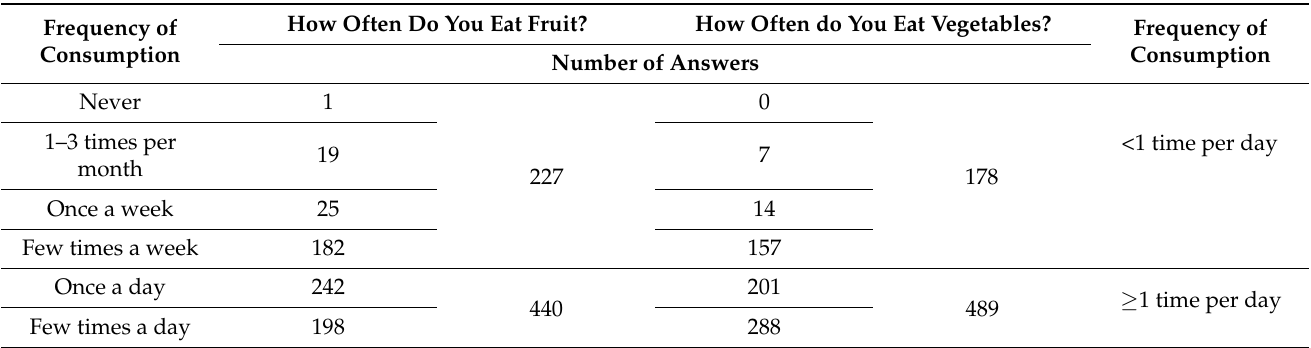
Table 2. The number of answers in the KomPAN questionnaire with regard to the frequency of consumption of fruit and vegetables ( n =